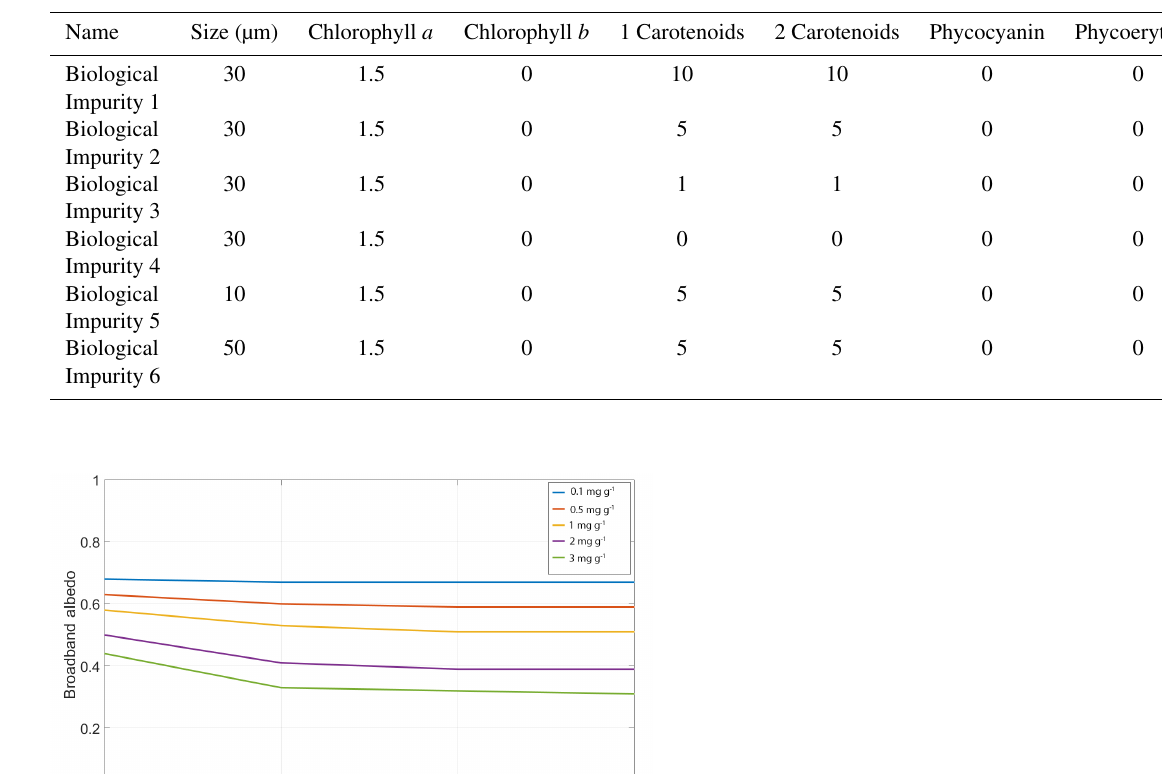
Table A1. Overview of cell size and pigment mass fractions (% total cell dry weight) for each biological impurity.